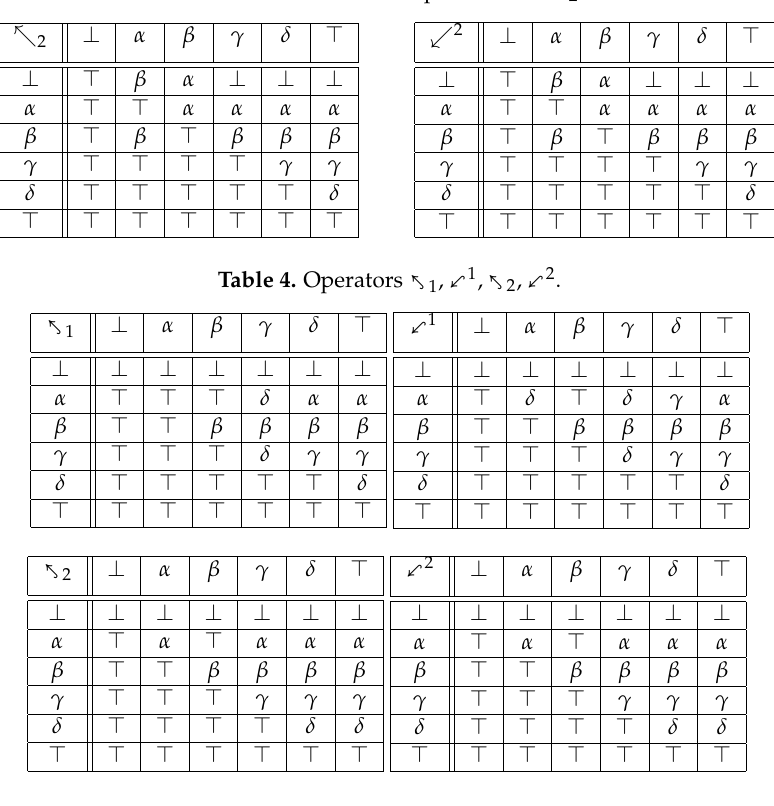
Table 3. Residuated implications of & 2 .